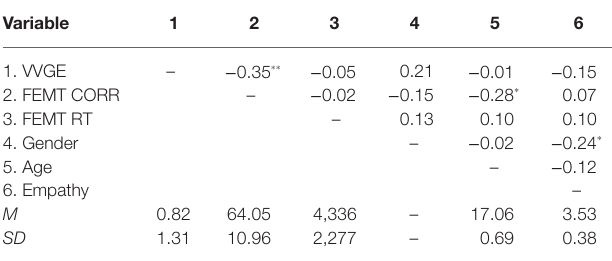
TABLE 1 | Means, SD, and correlations between violent game time playing and additional variables in Study 1 ( N = 67).